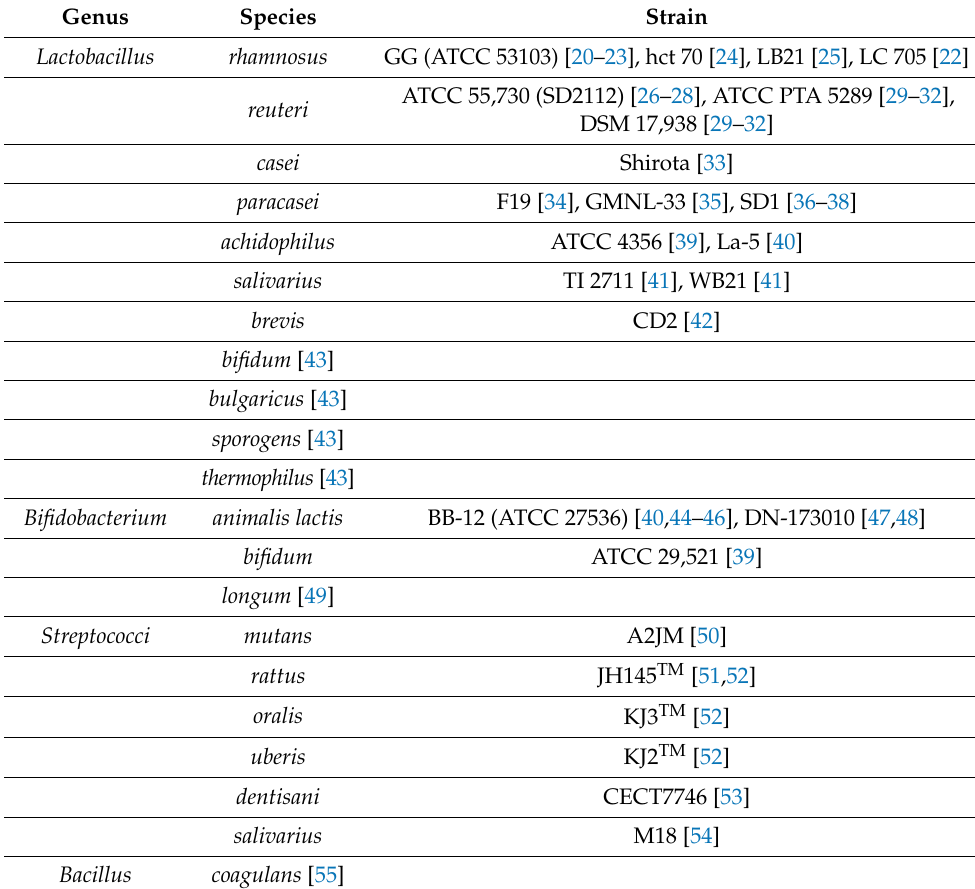
Table 1. Microorganisms are serving as oral